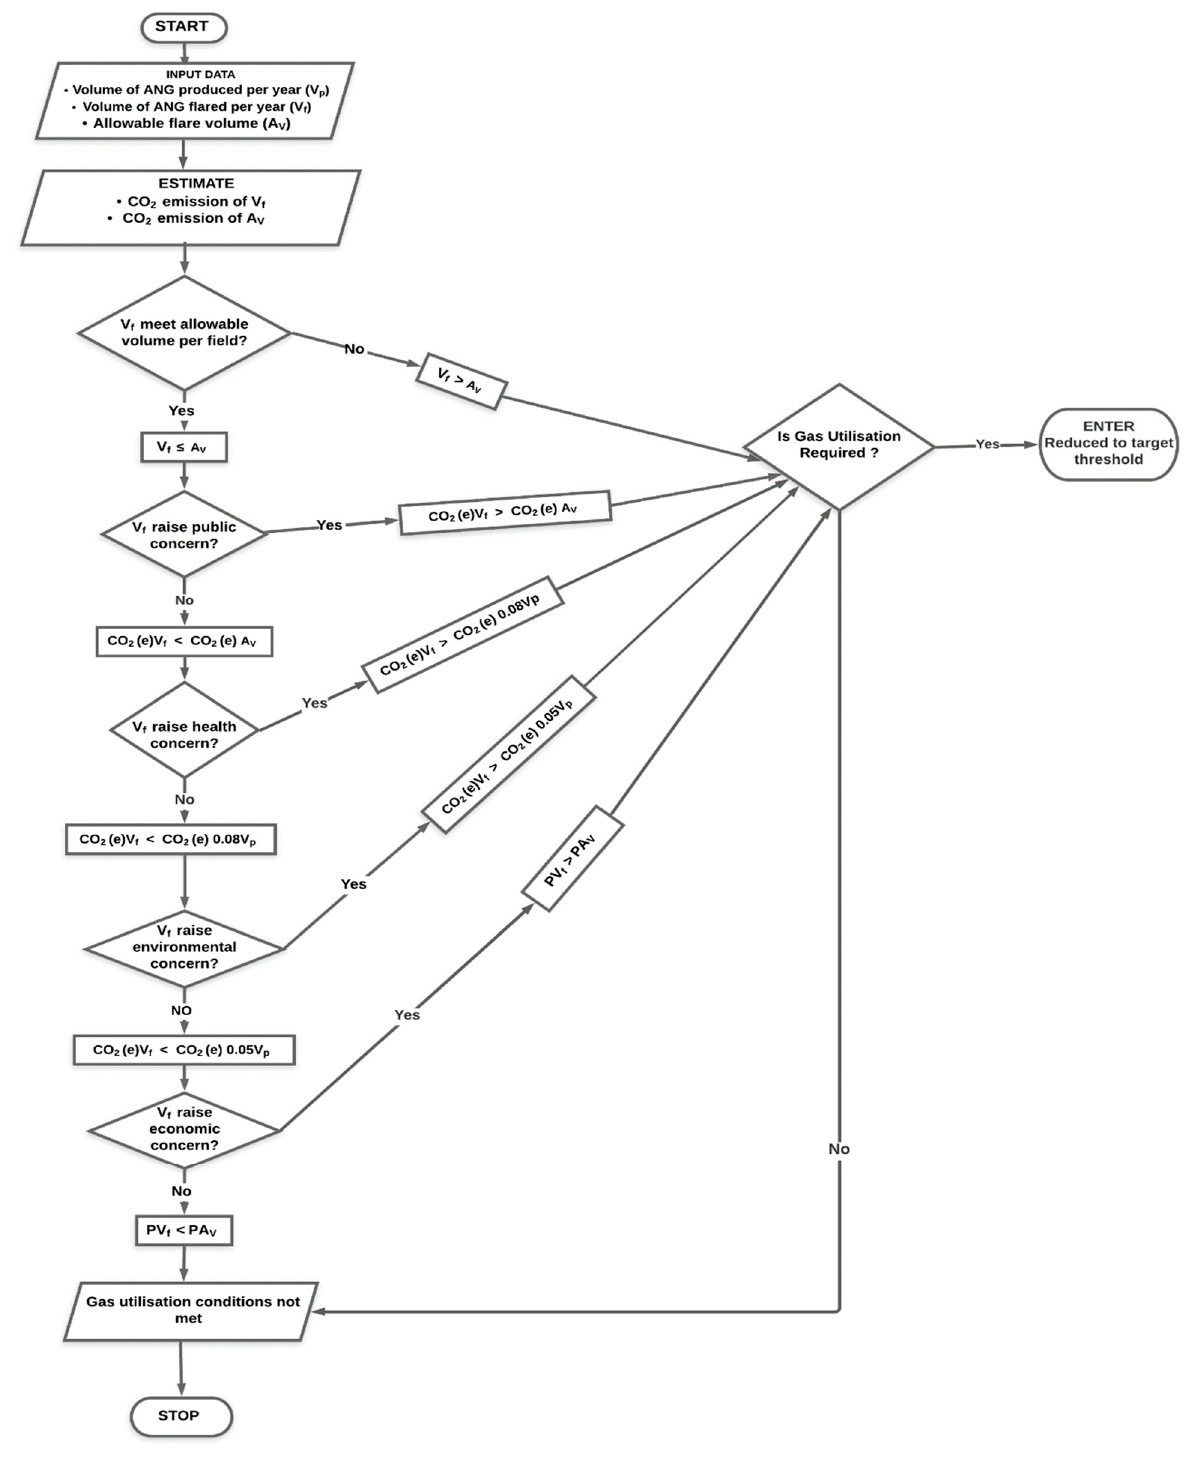
Figure 8. Decision Phase flowchart.